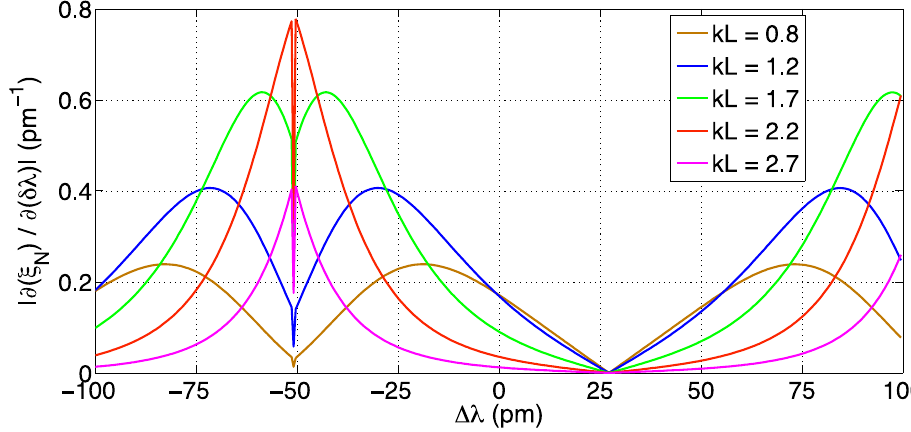
Figure 27. Evaluation of | ∂ ( ξ N )/ ∂ ( Δ λ ) | as a function of wavelength shift Δ λ , for different values of kL . Data are obtained for KLT applied to δλ = 156 pm.